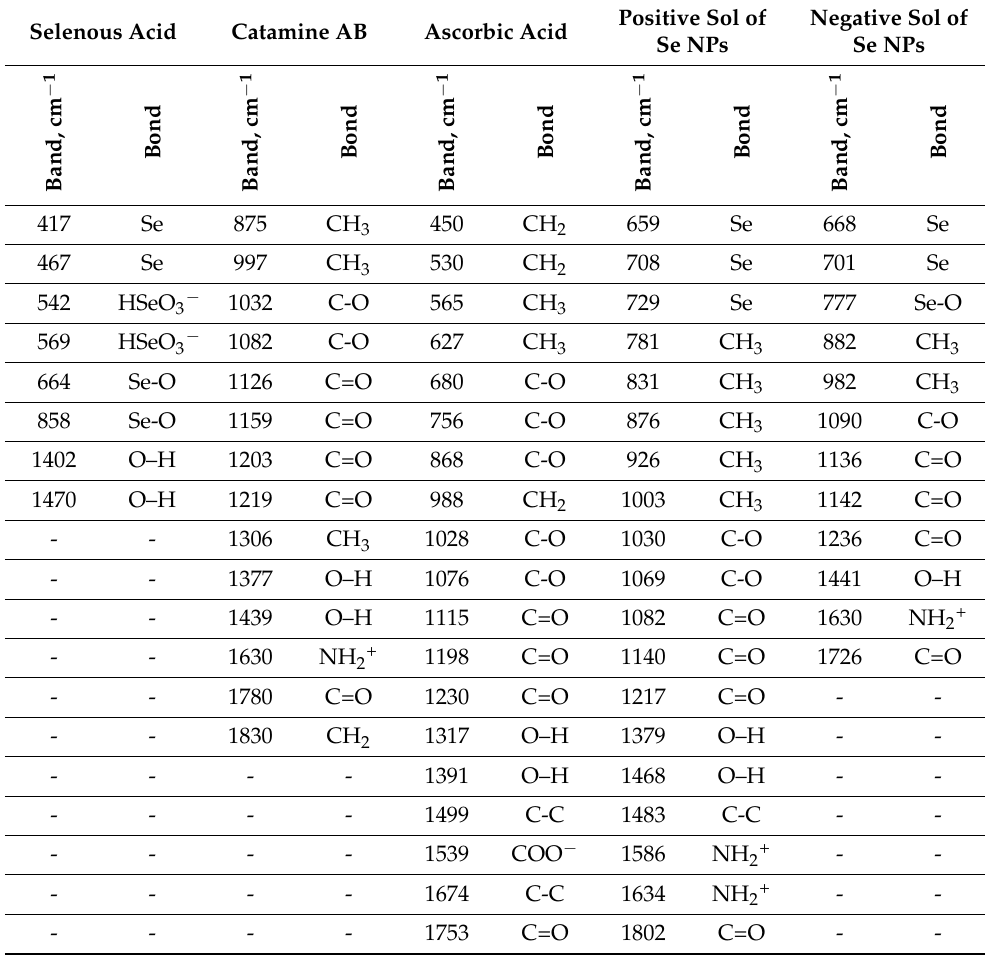
Table 7. Interpretation of the IR spectra of the obtained